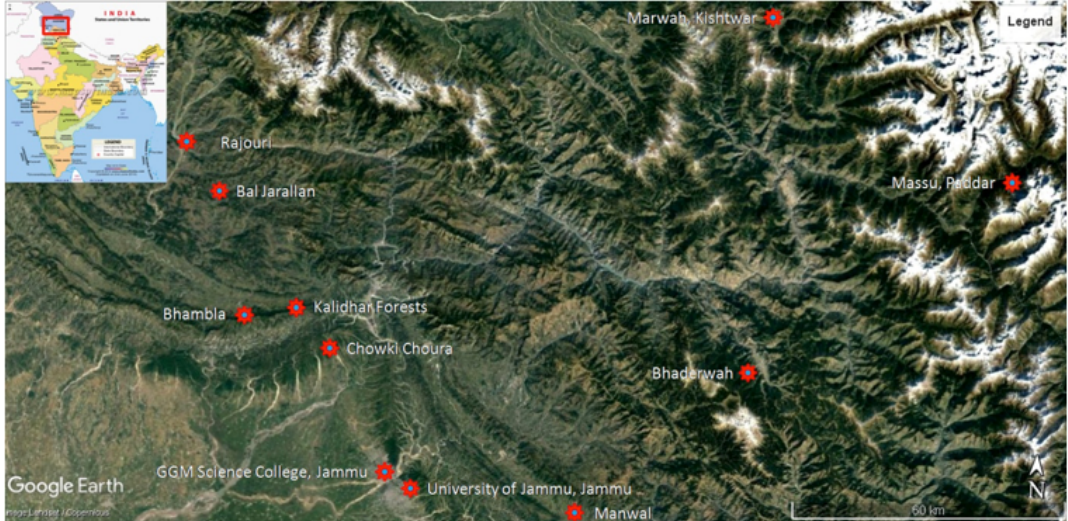
Figure 1. Study area showing locations of new butterfly